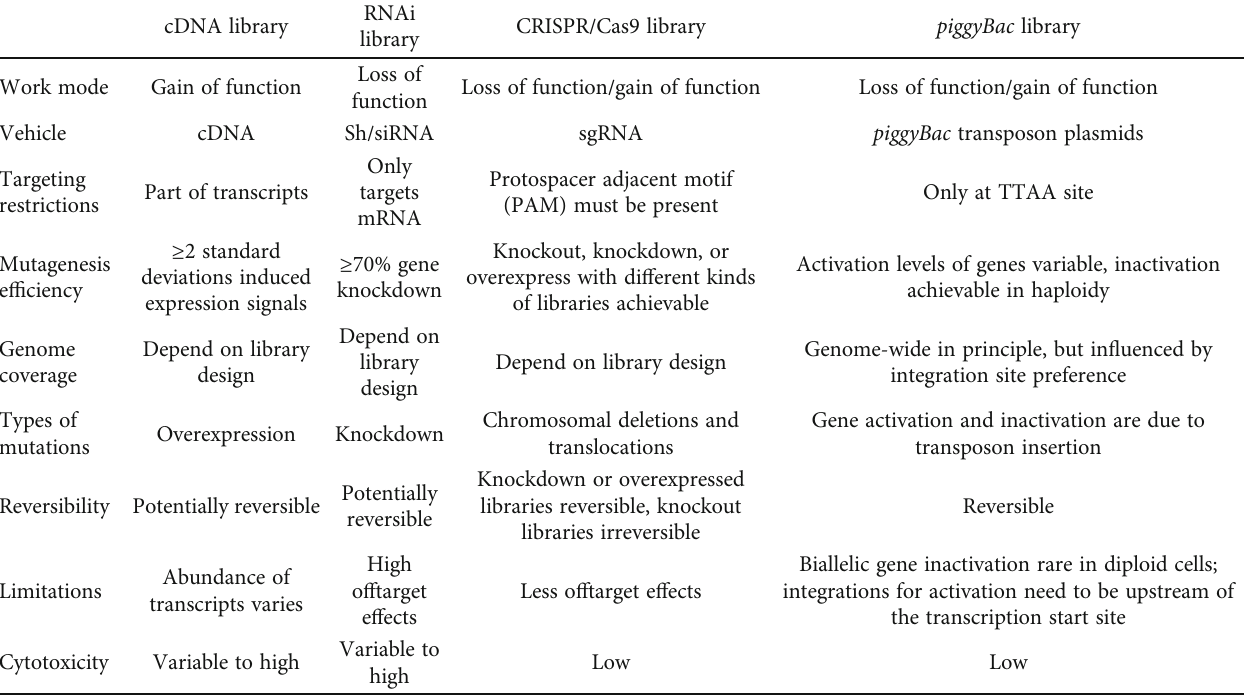
Table 2: Comparison of genome-wide screening libraries based on cDNA, RNAi, CRISPR/Cas9, and PB transposons. cDNA